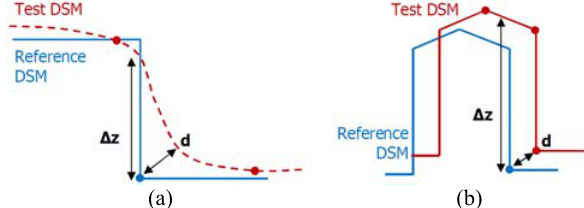
Figure 6. The sub-optimality between 1D elevation difference ( Δ z) and the spatial distance